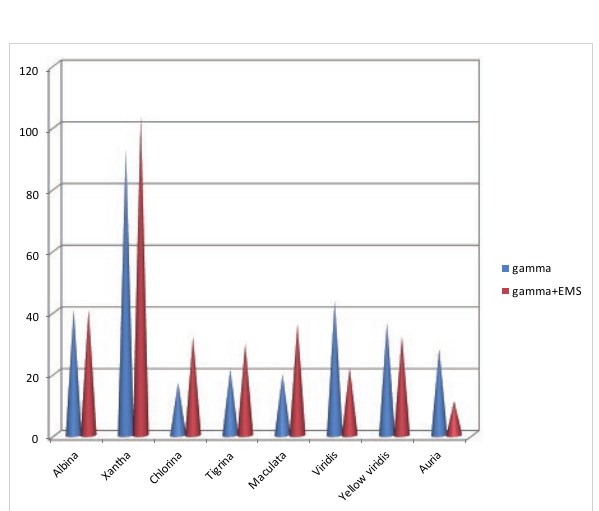
Figure 2. Chlorophyll mutations frequency on mutagen basis in Artemisia annua L.